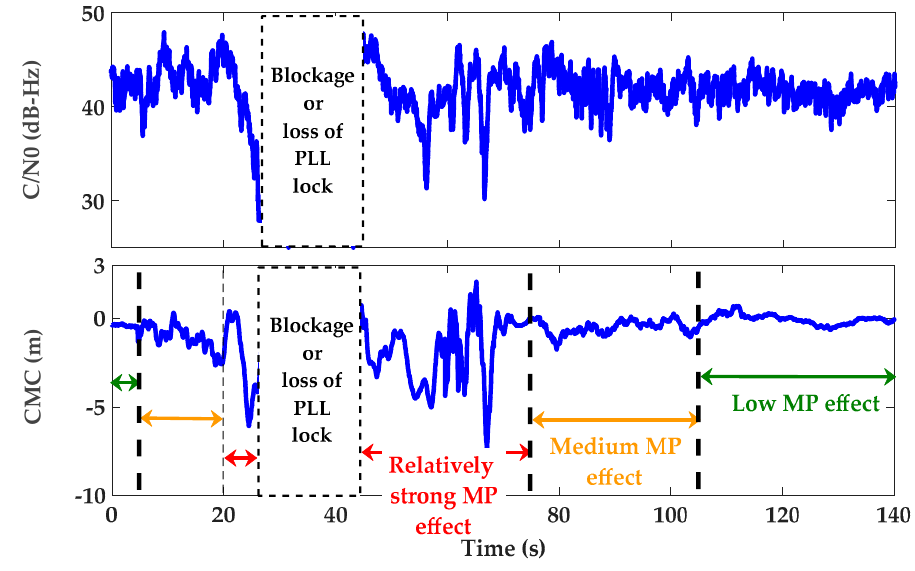
Figure 11. C/N 0 and CMC measurements for PRN 21 (as a clear example of different levels of multipath during different segments of the trajectory).